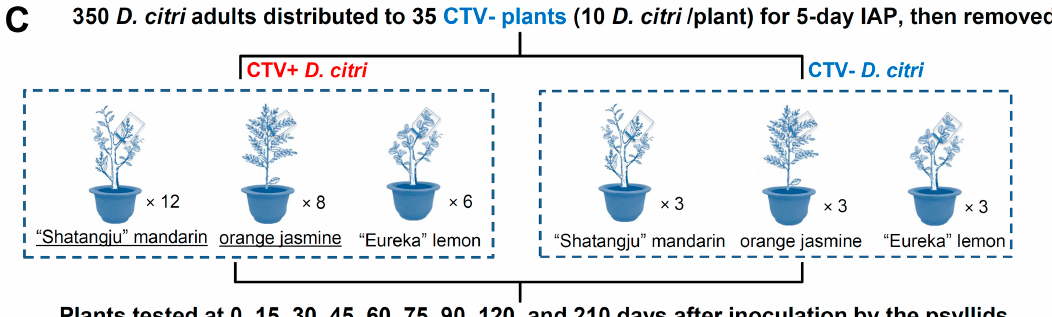
Figure 1. Experimental settings for testing acquisition of Citrus tristeza virus (CTV) by Diaphorina citri ( A ), viral persistence period within the psyllids ( B ), and CTV transmission capacity to healthy plants by Diaphorina citri ( C ). Groups of plants in figures B and C with their names underlined were the same used throughout the experiment. Groups highlighted in red were confirmed CTV-positive prior to each experimental step, and those highlighted in blue were confirmed CTV-negative prior to each experimental step. Legend: CTV+: CTV-positive; CTV-: CTV-negative; “Shatangju” mandarin: C itrus reticulata Blanco “Shatangju”; “Eureka” lemon: Citrus × limon var. limon (L.) Burm. f.; orange jasmine: Murraya paniculata (L.) Jack.; CTV+ D. citri : a group of D. citri with ~85% of them were CTV-positive; AAP: acquisition access period; IAP: inoculation access periods; 0 days: tested immediately after inoculation by psyllids.